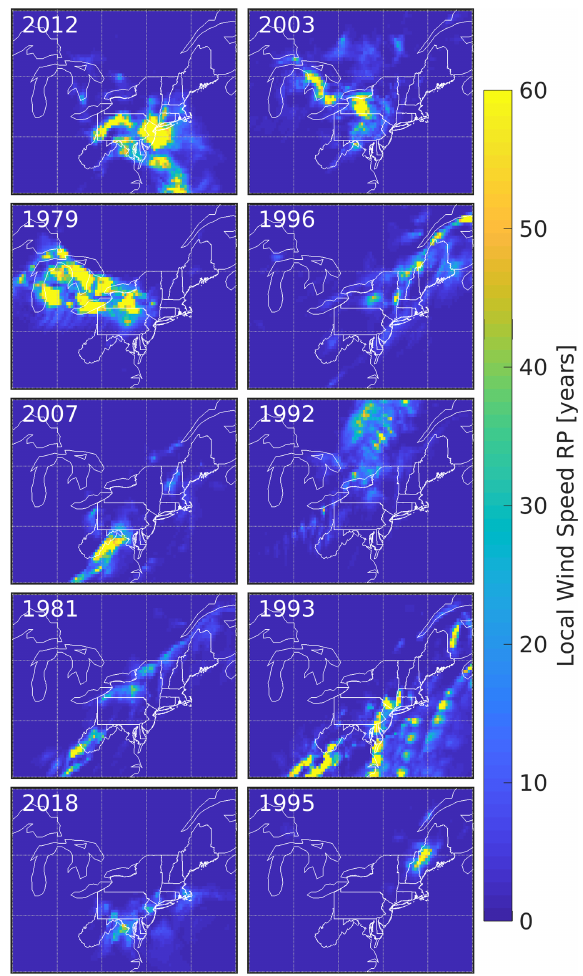
Figure 8. Return period (in years) of storm-maximum wind speed ( U peak ) in each ERA5 grid cell associated with each windstorm. The color scale is truncated at 60 years for legibility. But, for exam- ple, the RP of the maximum wind speeds at 100m during Hurricane Sandy (2012) exceeds 100 years for multiple grid cells. Northeast- ern state borders and coastlines (Atlantic Ocean and Great Lakes) are shown in white.